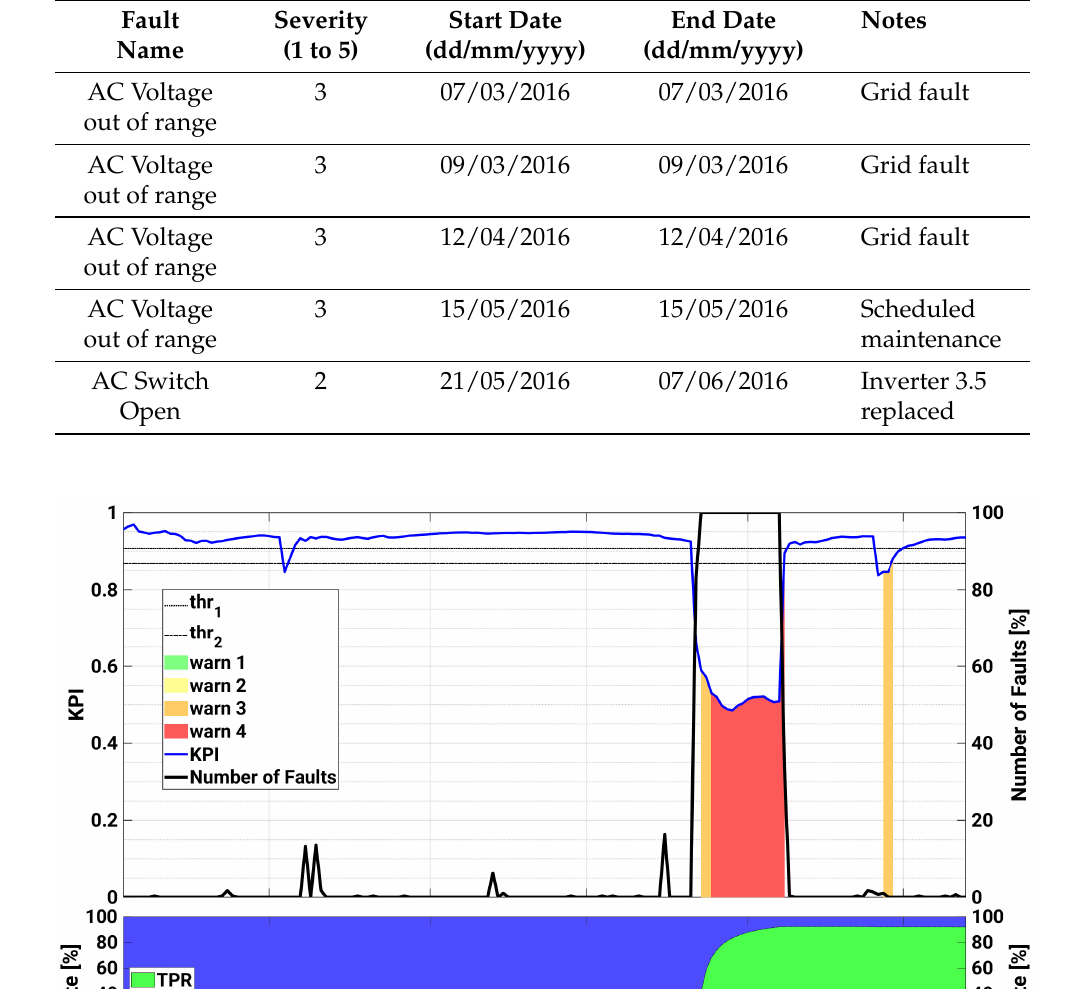
Table 7. Main failures occurring on inverter 3.5 of plant C during the testing period.